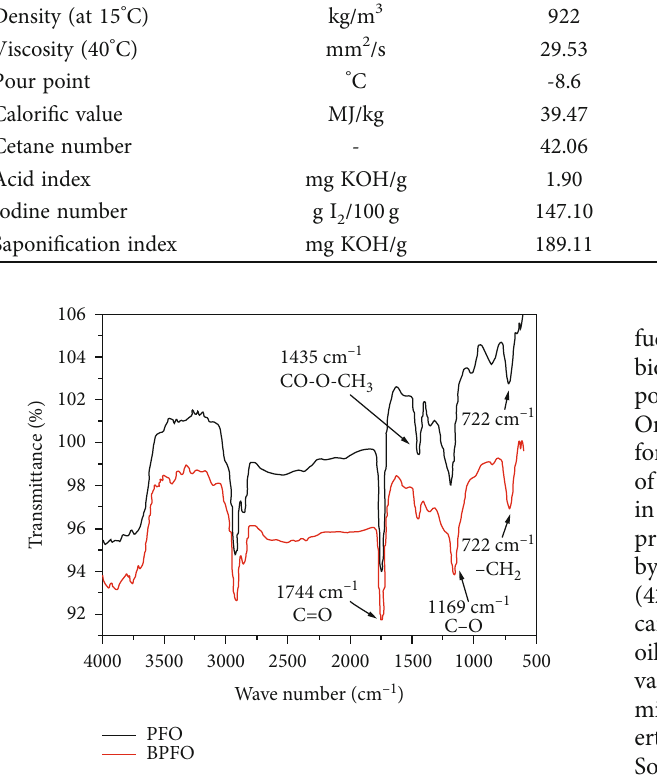
Figure 7: FT-IR spectra of Podocarpus falcatus oil (PFO) and biodiesel